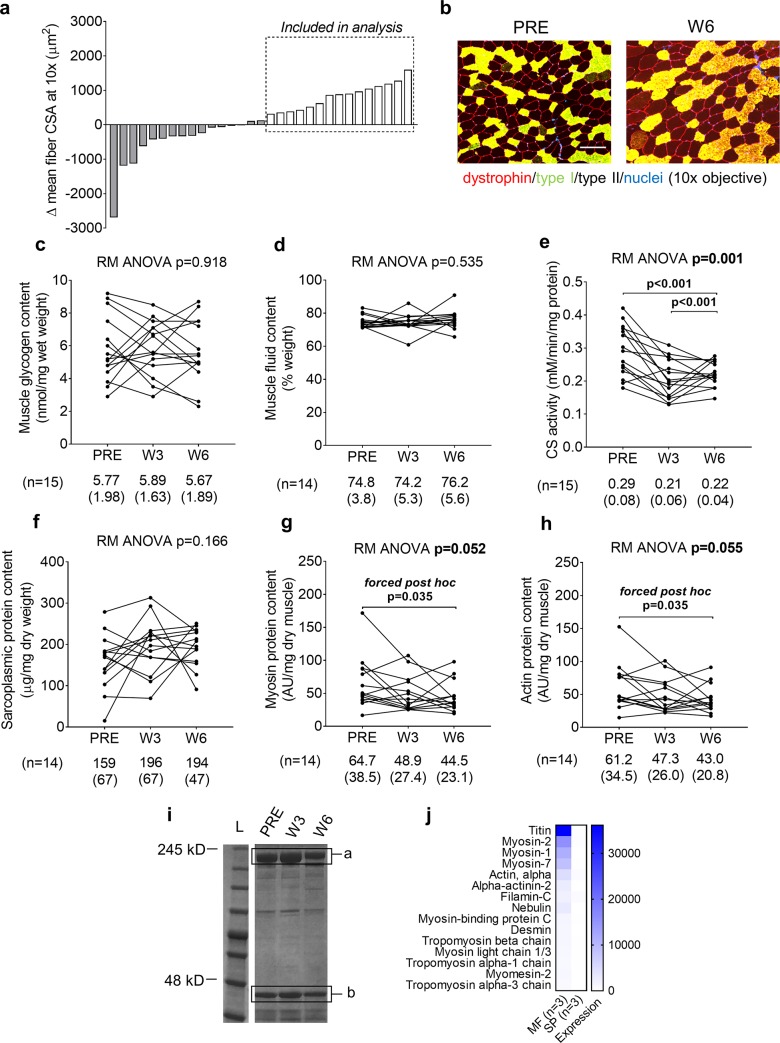
Right leg body composition and VL biopsy molecular adaptations in fCSA responders.All line graph data show individual responses with mean ± standard deviation (SD) values below each time point. Panel a demonstrates the 15 hypertrophic responders according to fCSA changes with training. Panel b illustrates a PRE and W6 representative 10× objective image from one subject (scale bar = 200 μm). No significant changes in VL biopsy glycogen concentrations (panel c), muscle fluid content (panel d), or sarcoplasmic protein concentrations (panel f) were observed. VL biopsy citrate synthase activity (a surrogate of mitochondrial volume) significantly decreased over time (panel e). VL biopsy myosin protein (panel g) and actin protein (panel h) concentrations significantly decreased from PRE to W6. Panel i illustrates representative myosin (band a) and actin (band b) Coomassie stains from one subject. Panel j demonstrates that the utilized myofibrillar and sarcoplasmic isolation methods demonstrated excellent enrichment of contractile proteins in the former fraction, and little contamination of contractile proteins in the latter fraction (both fractions from n = 3 random participants were assayed).